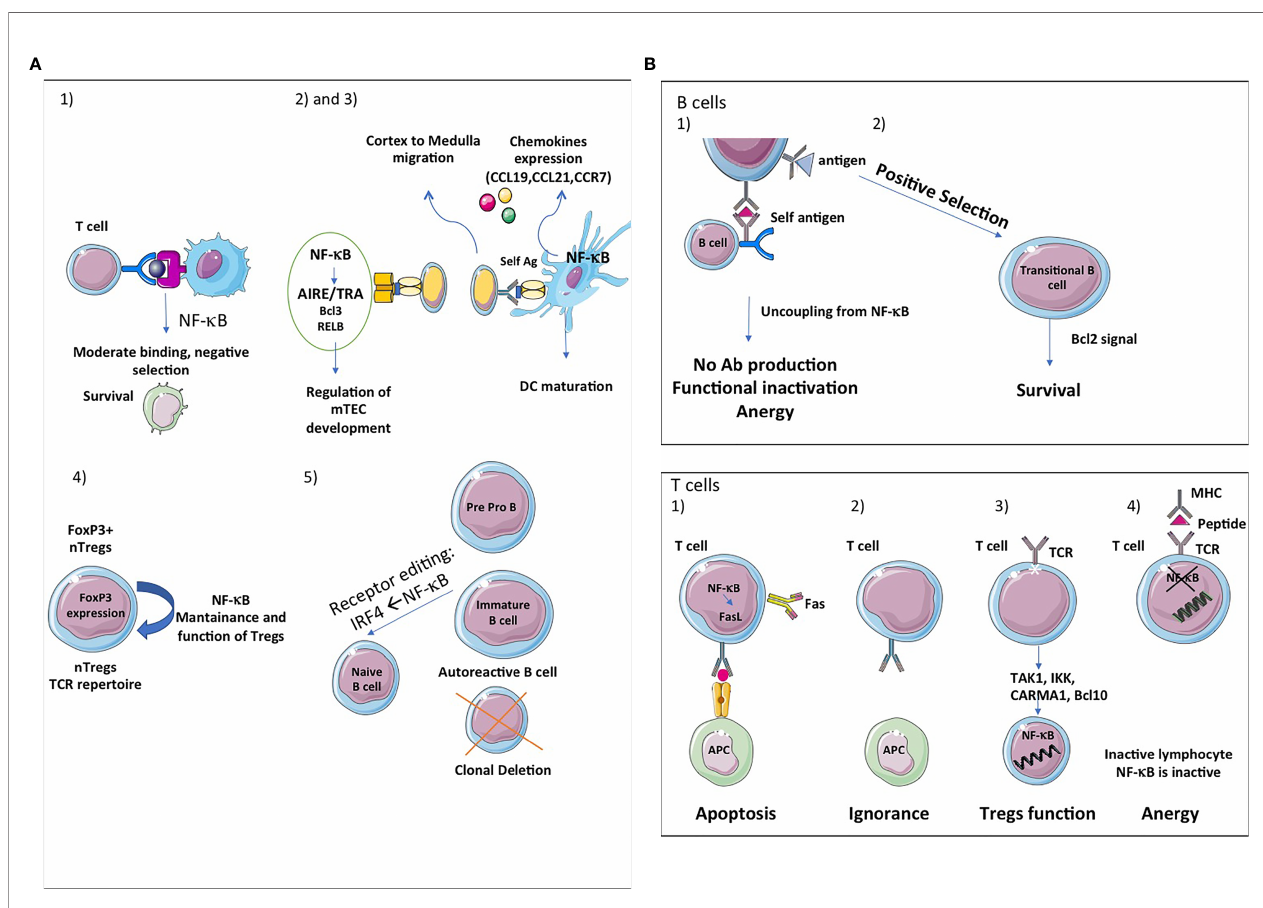
FIGURE 5 | NF- k B, a key player in central and peripheral immune tolerance. (A) Central tolerance: The thymic stroma is crucial for the growth, differentiation, positive and negative selection of the T-cell receptor repertoire. The thymic stromal compartment is composed of epithelium, fi broblasts, endothelium, macrophages and dendritic cells, each of which has a distinct role in T-cell development. Single-positive (SP) thymocytes after positive selection have to migrate into medulla to undergo negative selection and further maturation, given the critical role of mTECs in presenting tissue-restricted antigens (TRAs). The thymic medulla is indeed the main site for both negative selection of autoreactive thymocytes and positive selection of Tregs, two important central tolerance mechanisms. (1) First, the classical and alternative pathway of NF- k B activation contributes to the survival of immature cells during the negative selection and thereafter. (2) Second, the alternative NF- k B pathway regulates AIRE/TRAs expression and is involved in mTEC development, homeostasis and function. Bcl3 and RelB also regulate mTEC development at the DNA level. The deubiquitinase CylD is implicated in mTEC differentiation (3). Third, NF- k B also regulates the expression of chemokines (CCL19, CCL21, CCR7) implicated in cortex to medulla migration of DP thymocytes and to secondary lymphocytes organs and tissues. (4) Fourth, the NF-kB pathway has also been shown to in fl uence thymic or natural Treg (nTreg) cells development and function. These cells recognize self-antigens and play an important role in the maintenance of immunological self-tolerance. Forkhead Box P3 (FOXP3) is the main transcription factor for the differentiation of these cells. NF- k B is important for the maintenance and functions of nTregs and the expression of FOXP3. (5) Fifth, in B cells, NF- k B participates in clonal deletion of autoreactive B lymphocytes and receptor editing, a protective mechanism of ongoing gene rearrangement that generates a new receptor with an innocuous speci fi city that prevents cell death by apoptosis. If the BCR recognizes sel-antigen, it is down regulated under the control of IRF4 , a target gene of NF- k B. (B) Peripheral tolerance: Peripheral tolerance takes place in the periphery and its purpose is to ensure that T cells and B cells that escape from the thymus cannot give rise to autoimmunity. NF- k B signaling is essential for the development and maintenance of secondary and tertiary lymphoids organs. In B cells, peripheral tolerance uses two different mechanisms: (1) Anergy, which is characterized by desensitization of BCR signalling and its uncoupling from the NF- k B pathway, resulting in a failure of antigen presentation and antibody production. (2) NF- k B is essential for the survival of developing B cells in the spleen. Bcl2 is involved in the survival of transitional B cells. The classical and alternative pathways pathway of NF- k B activation are involved in B cells maturation. In T cells, peripheral tolerance uses four different mechanisms: (1) Inactivation of effector T cells by clonal deletion. Programmed cell death (apoptosis) is an essential mechanism leading to clonal deletion of T cells with high af fi nity for self-antigens. NF- k B plays a pro-apoptotic role in negative selection. (2) T-cells ignore certain self-antigens because they are located in immune-privileged sites or because they have low immunogenicity (low levels of expression or low binding af fi nity). (3) Conversion of T cells in Tregs. Non canonical NF- k B activation is important for the maintenance of these cells in vivo via its effect on mTEC development and canonical NF- k B plays is involved in Foxp3 expression which is fundamental for the function of Tregs. Components of the TCR-mediated NF- k B pathway such as TAK1, IKK, CARMA1 and Bcl10 are also involved in Tregs development. Ubiquitination is fundamental for Tregs functions. (4) Induction of anergy. Anergy is a tolerance mechanism in which lymphocytes are intrinsically functionally inactive. NF- k B is inactive in these unresponsive lymphocytes. NF- k B also controls DCs